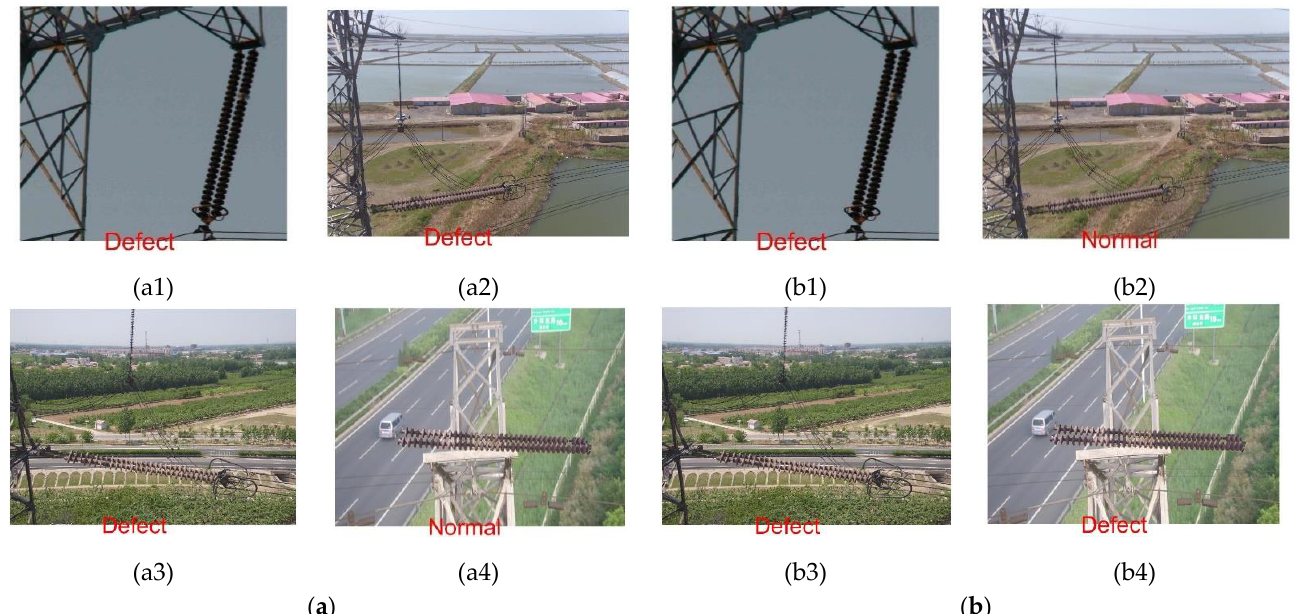
18 of 22 Table 7. Insulator image classification results. GWO-SVM PSO-SVM Normal Insulator Diagram Defective Insulator Diagram Normal Insulator Diagram